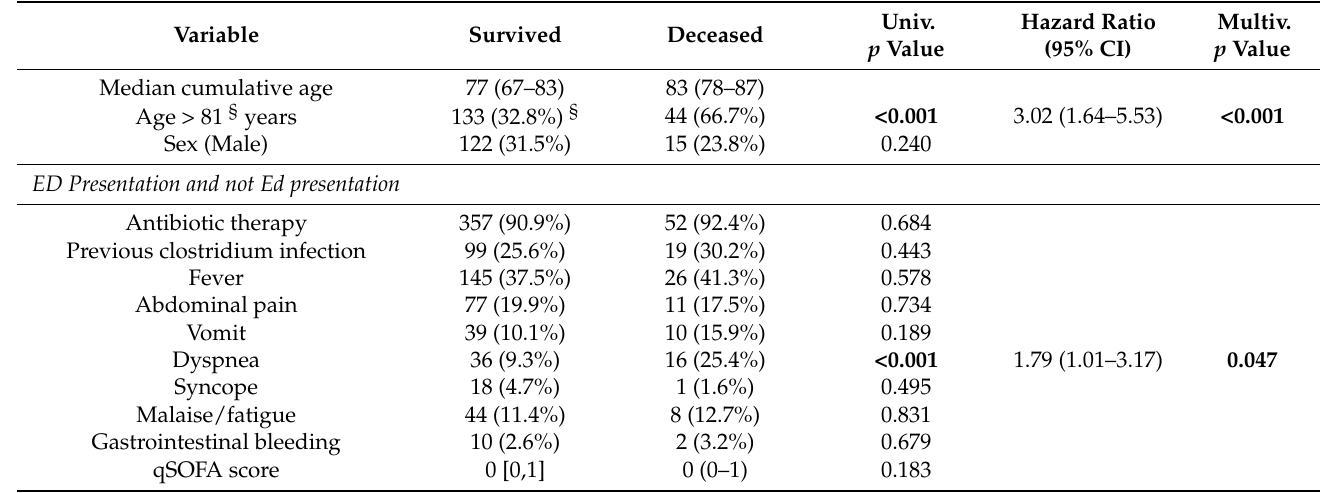
Table 2. The univariate and multivariate comparison regarding all-cause in-hospital